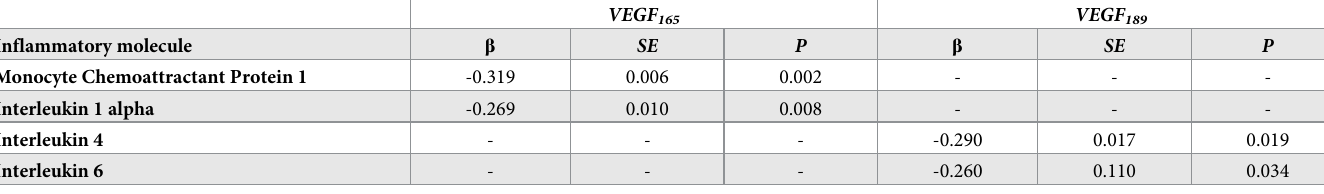
Table 6. Significant associations between the expression of VEGF mRNA isoforms and inflammatory molecules (linear regression models adjusted for age and